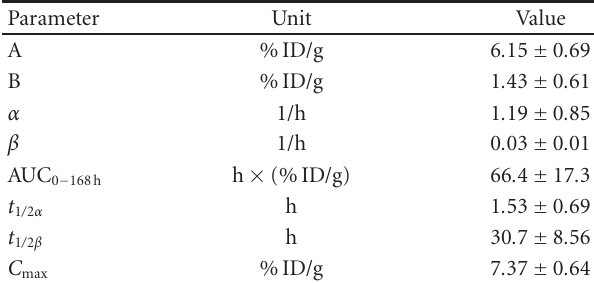
Table 2: Pharmacokinetic parameters of plasma in PC-3 tumor- bearing mice after intravenous injection of 10 μ Ci/mouse 111 In- AMBA (mean ± SEM, n = 5).